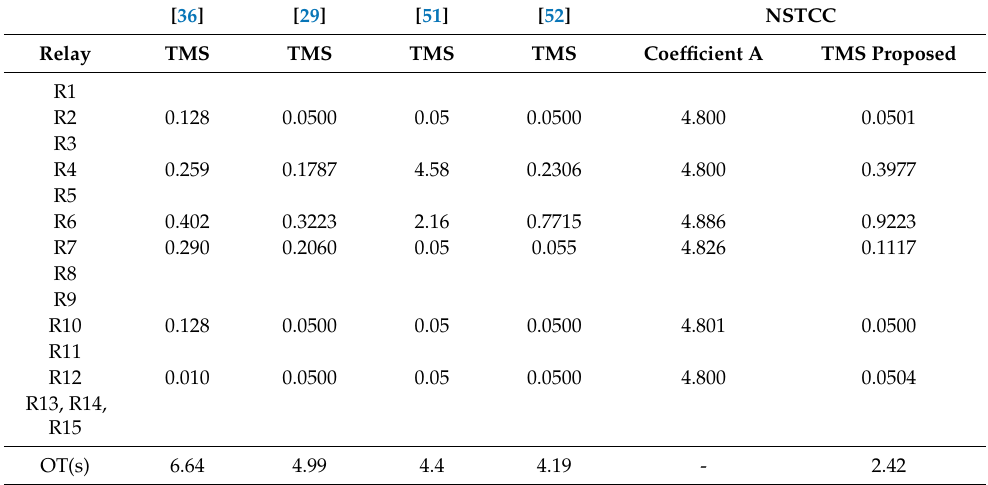
Table 6. The Overall OT for the radial IEC MG—Mode